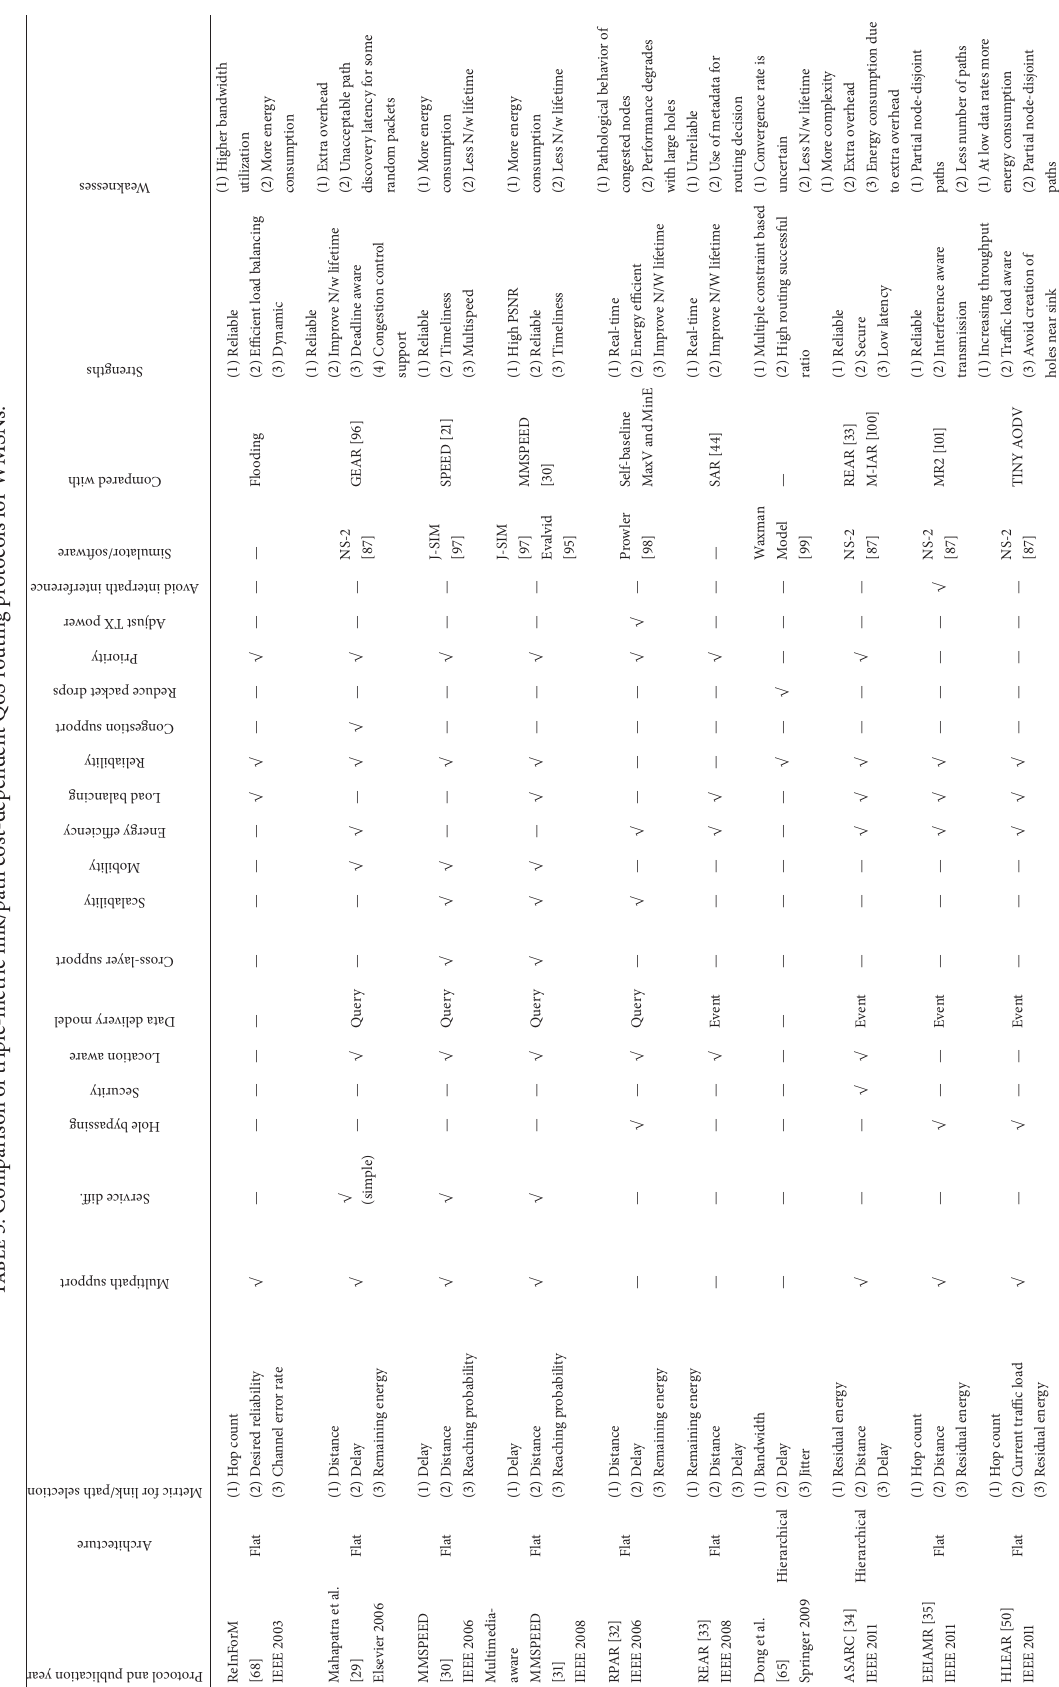
Protocolandpublicationyear